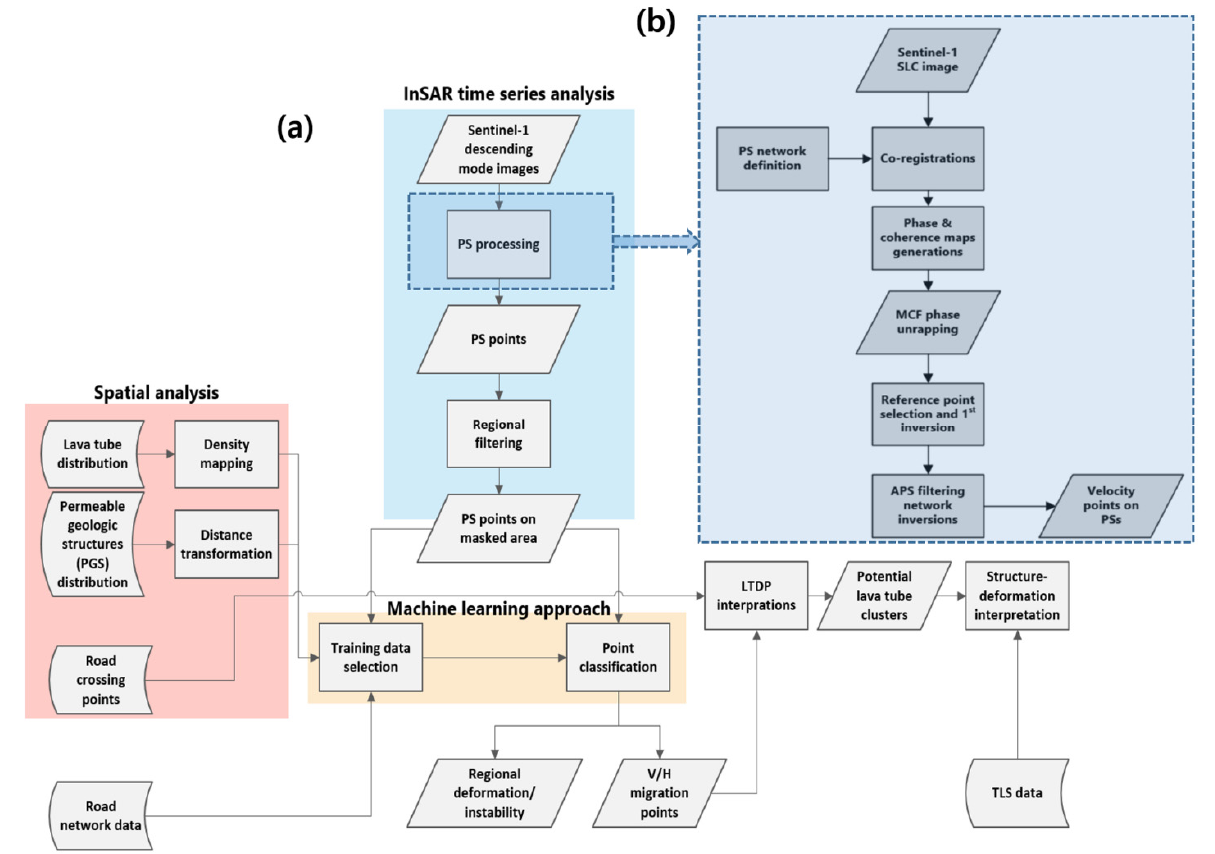
Figure 2. ( a ) Overall processing flow to define LTDP and ( b ) PS